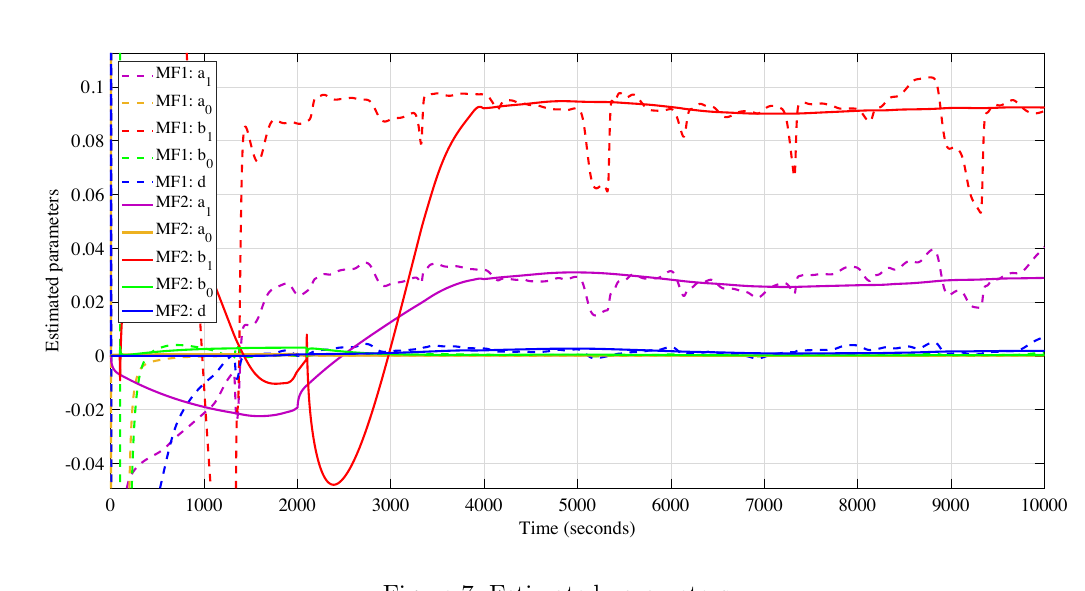
Figure 7: Estimated parameters